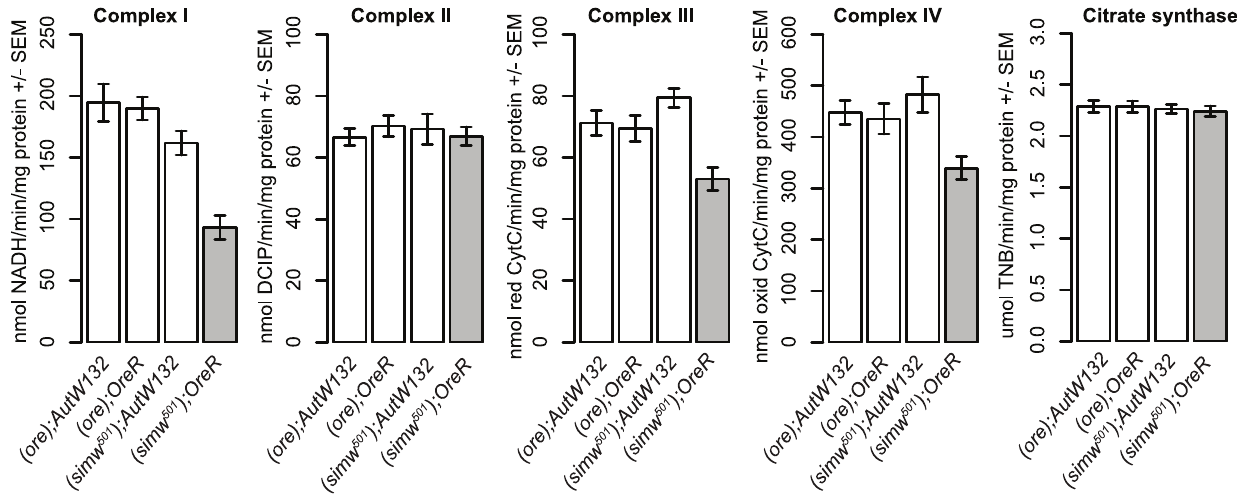
Figure 6. The mitochondrial-nuclear incompatibility decreases the activity of OXPHOS complexes that are mitochondrially translated. ( simw 501 ); OreR individuals have significantly reduced activities of OXPHOS complexes I, III and IV, which contain subunits encoded in the mtDNA and translated in mitochondria (mtDNA 6 nuclear, P ANOVA , 0.01, each complex). In contrast, the activities of complex II and citrate synthase, which function in the mitochondria but are encoded entirely by nuclear genes and translated in the cytoplasm, are similar across genotypes (mtDNA 6 nuclear, P ANOVA . 0.20, both activities). Plots combine male and female data, as the mitochondrial-nuclear interaction effects were the same in both sexes (Table